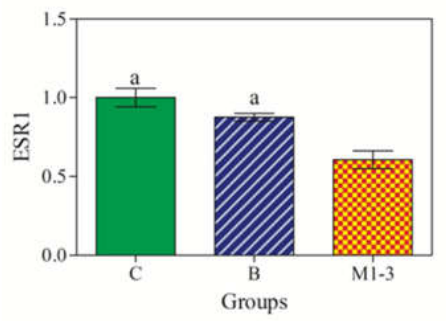
Figure 6. RT-qPCR expression levels of ESR1 mRNA. ESR1 expression was downregulated in malignant tumors (M1–3; orange color) compared with control (C; green color) and benign tumors (B; blue color). Significances ( p < 0.001): a vs. Group M1–3.